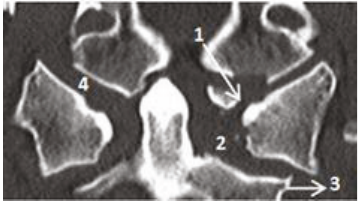
Figure 1: Cervical spine CT scan showing type III left occipital condyle fracture (1), asymmetric left odontoid-lateral mass widening (2), lateral subluxation of bilateral C1 lateral masses (3), and widening of the right atlantooccipital joint